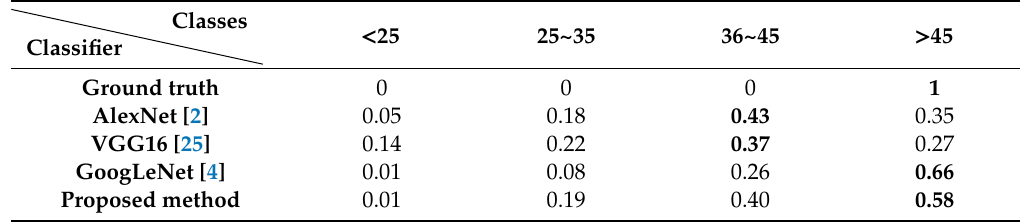
Figure 13. An example photo from the CACD2000 database. Table 18. Recognition results of the CACD2000 photo.